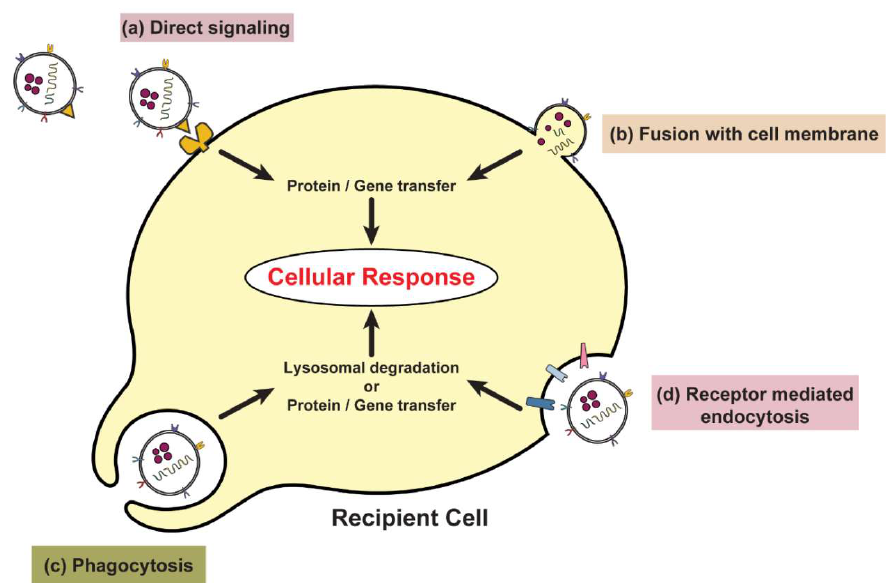
Figure 4. Exosome interaction and internalization by recipient cells. Interaction and / or internalization of exosomes by target cells lead to activation of various signaling pathways and transfer of exosomal contents, culminating in a cellular response. Exosomes may interact with target cells by